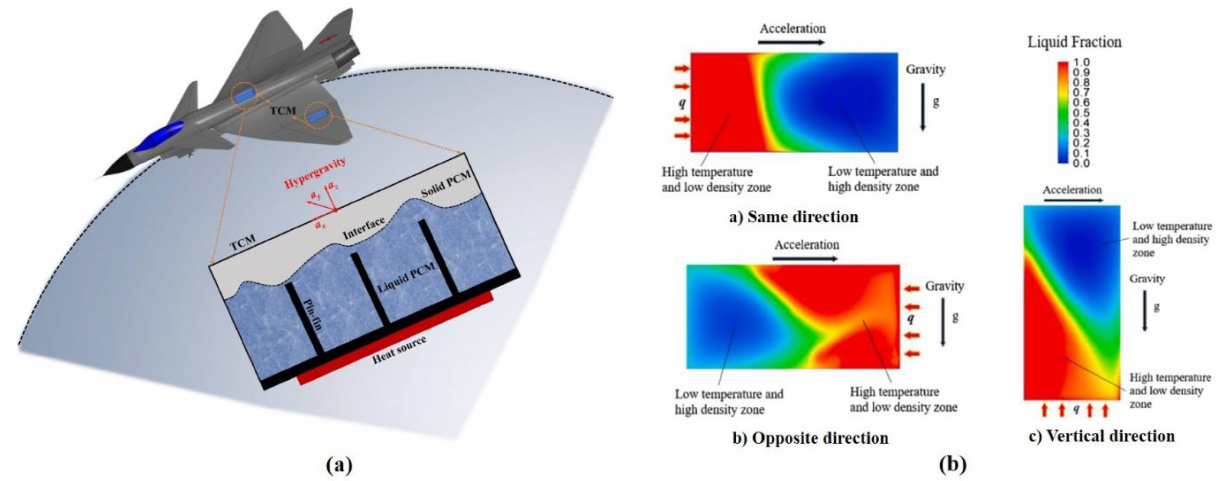
Figure 18. Schematic of ( a ) the PCM device on board aircraft under hypergravity condition and ( b ) PCM melting process in different acceleration directions [183,185].